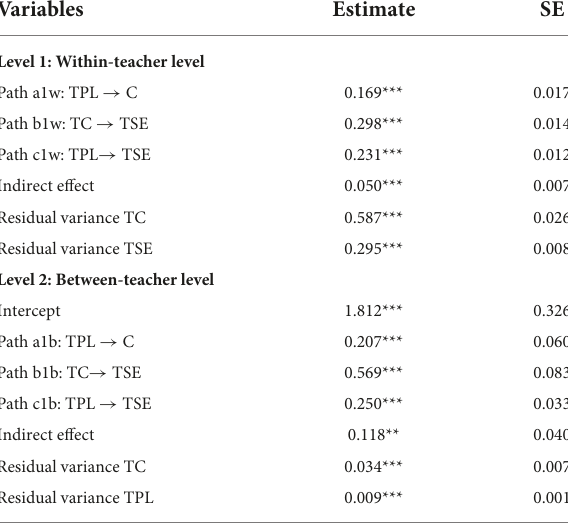
TABLE 2 Coefficients for the multilevel mediation model predicting teacher self-efficacy.